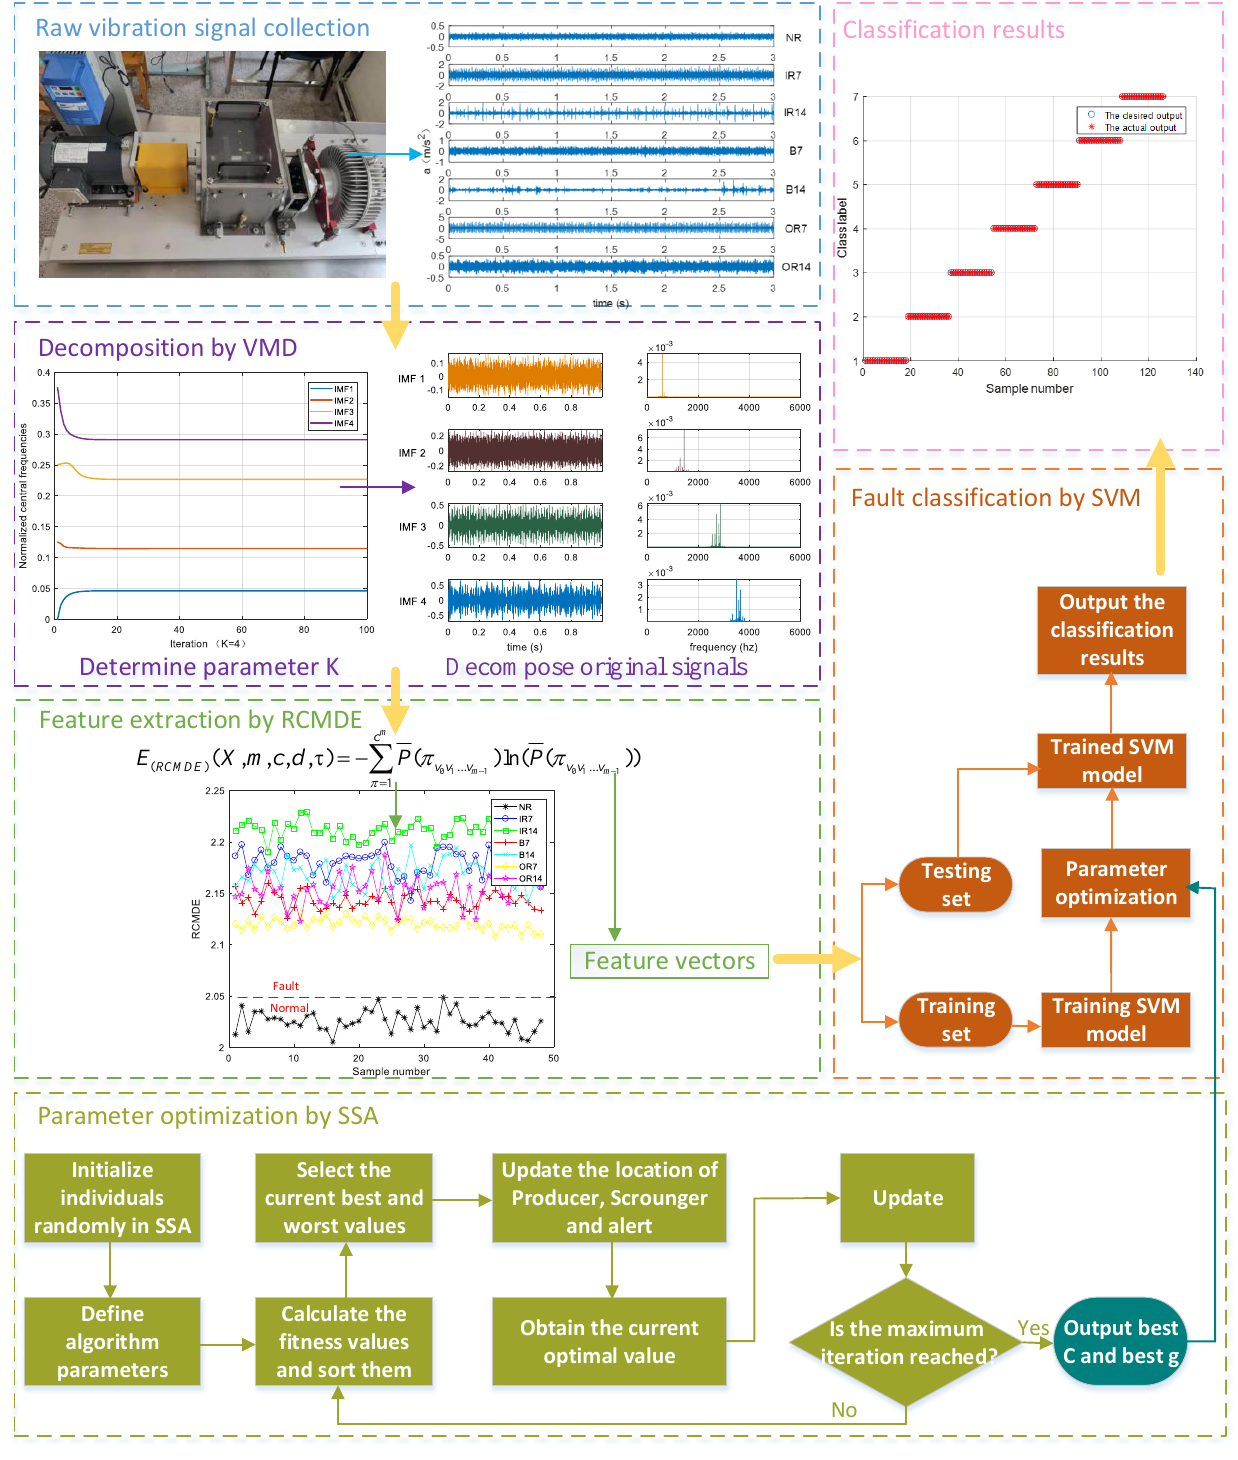
Figure 1. Technical roadmap of bearing-fault diagnosis.